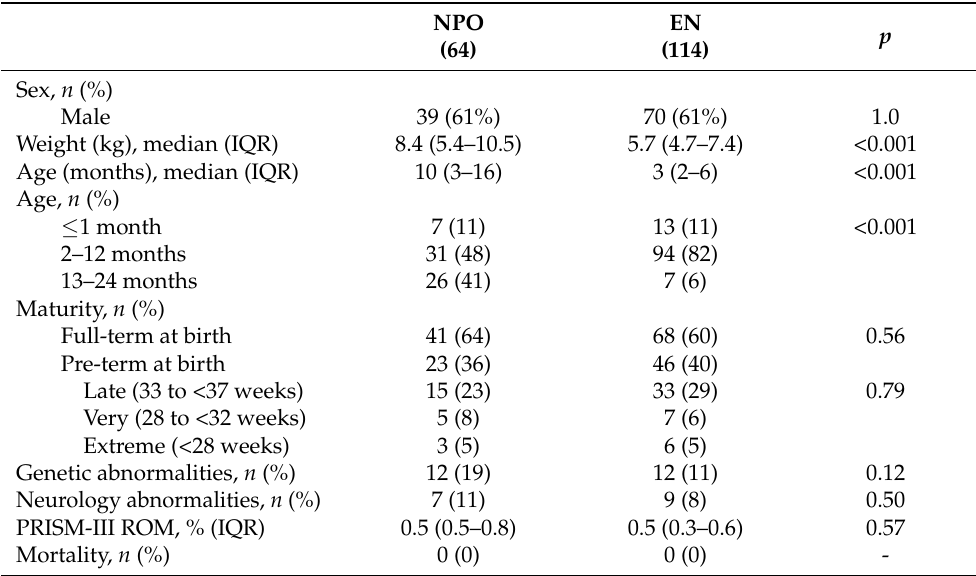
Table 1. Demographic Data for Entire Cohort ( n = 178).